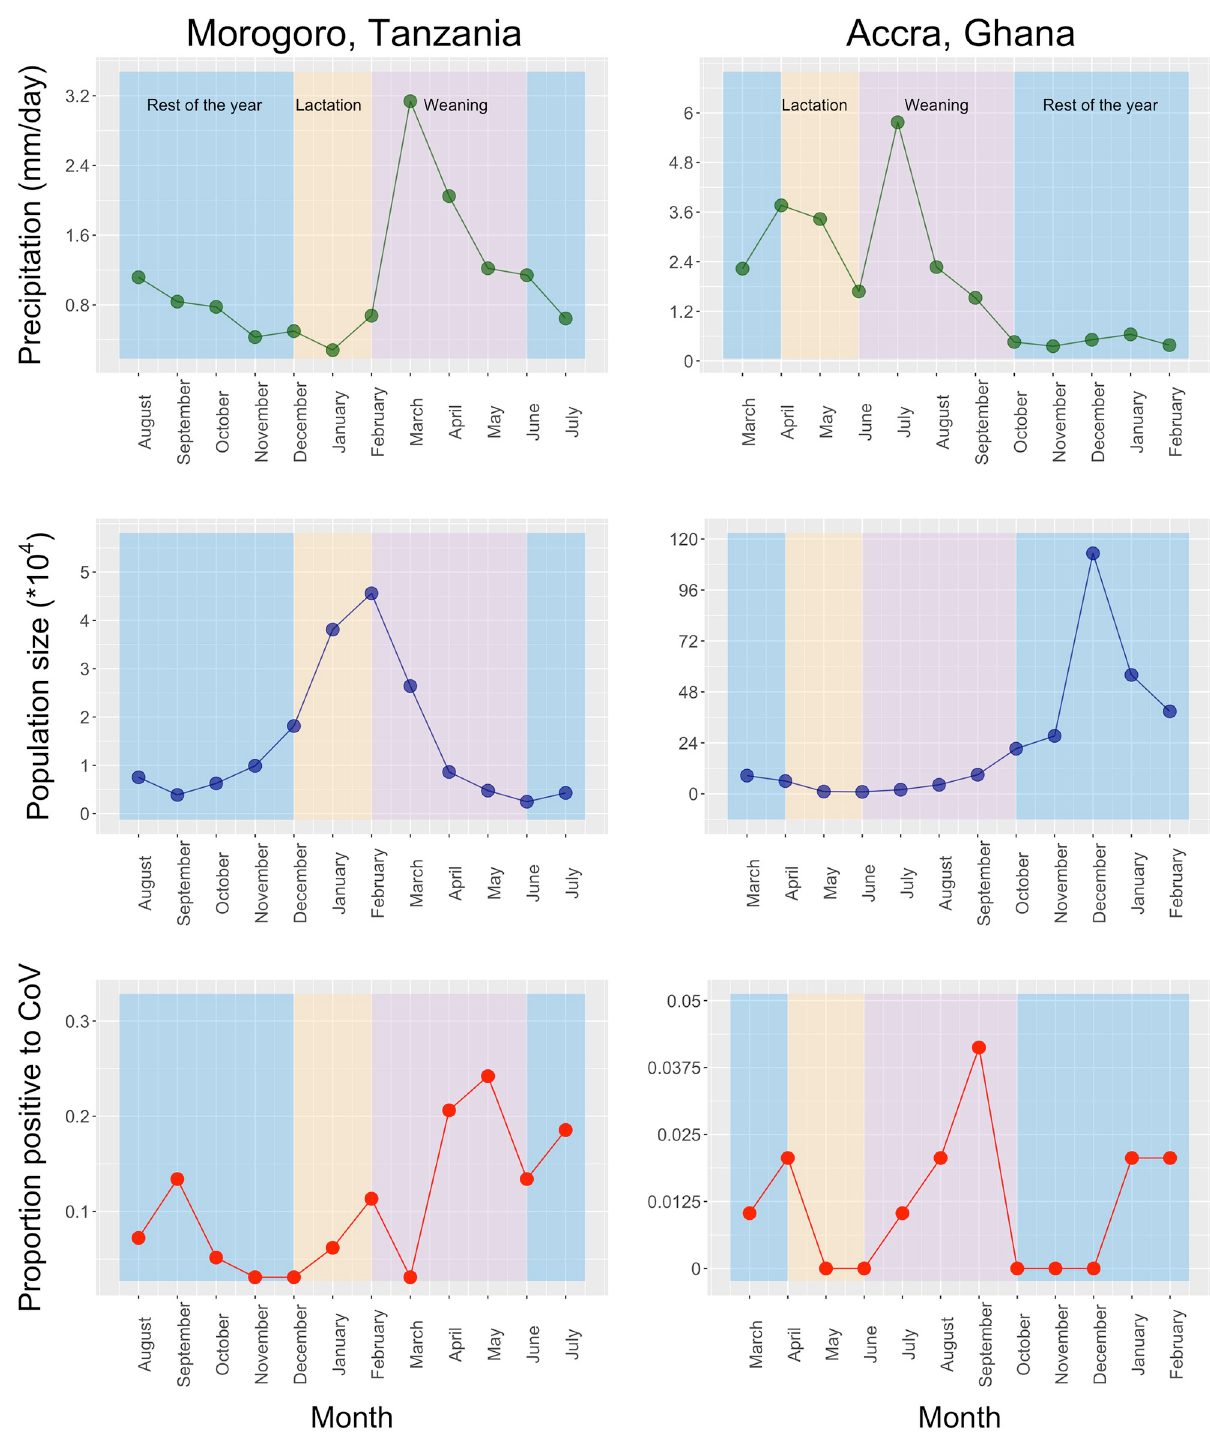
Fig 2. Eidolon helvum monthly abundance (blue line), precipitation (green line), and coronavirus shedding (red line) at the roost in Morogoro, Tanzania (left); and at the roost in Accra, Ghana (right). Color bands indicate the “lactation” (orange), “weaning” (purple), and “rest of the year” (blue) reproductive